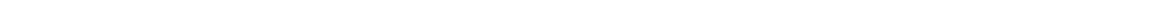
Fig. 2 PGRN prevents Gas6 interaction with Tyro3. a PPI network of MARCKS retrieved from String (http://string91.embl.de/, http://string-db.org/) suggests that Tyro3 is a candidate receptor related to MARCKS. b Downstream molecules of TNFR and Tyro3 were retrieved from PPI database of the Genome Network Platform of the National Institute of Genetics (http://genomenetwork.nig.ac.jp/index_e.html), from which Top100 molecules with highest centrality scores (betweenness and eigenvalue) were listed. 10 molecules are shared by Top100 lists of TNFR and Tyro3, in which Shc and Grb2 are identi fi ed as critical signal mediators. c Interaction of Gas6 with the plasma membrane in primary cortical neurons expressing Tyro3-TurboGFP, and inhibition of this interaction by PGRN. d SPR analysis revealed Gas6 binding to Tyro3 and the inhibition of this interaction by PGRN (left panel). BDNF did not inhibit binding of Gas6 to Tyro3 (right panel). e , f , g Af fi nities of Gas6, PGRN, and BDNF to Tyro3 were evaluated by SPR. Gas6, but not PGRN or BDNF, bound Tyro3 with high af fi nity. h PGRN bound Gas6 at high af fi nity. i BDNF did not bind to Gas6. j Pre-incubation of Gas6 with PGRN decreased the af fi nity of Gas6 for Tyro3. k Pull-down assay revealed direct interaction between PGRN and Gas6. His-tagged proteins were pulled down by Ni-NTA-agarose, and GST-tagged proteins were pulled down by glutathione